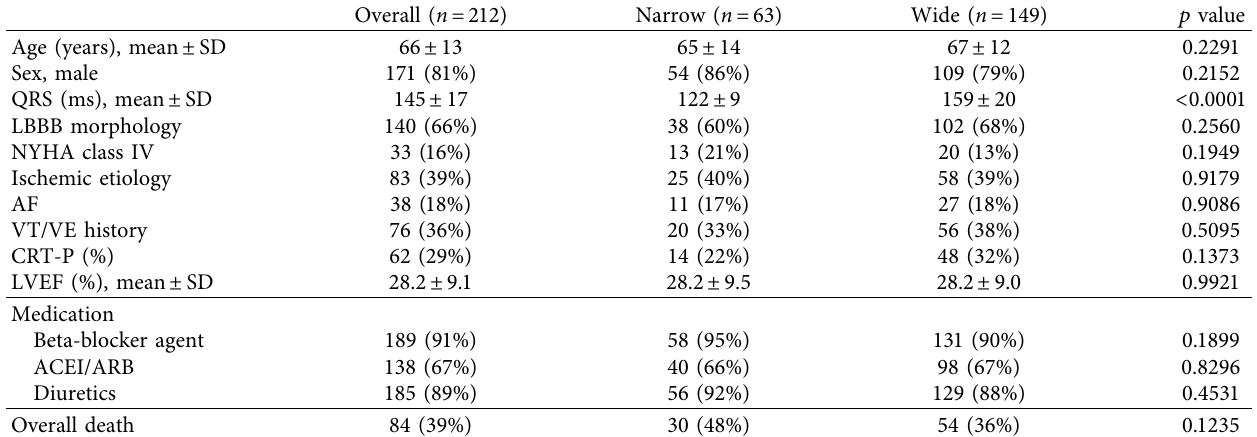
Table 1: Patient characteristics: overall, narrow, and wide QRS groups.